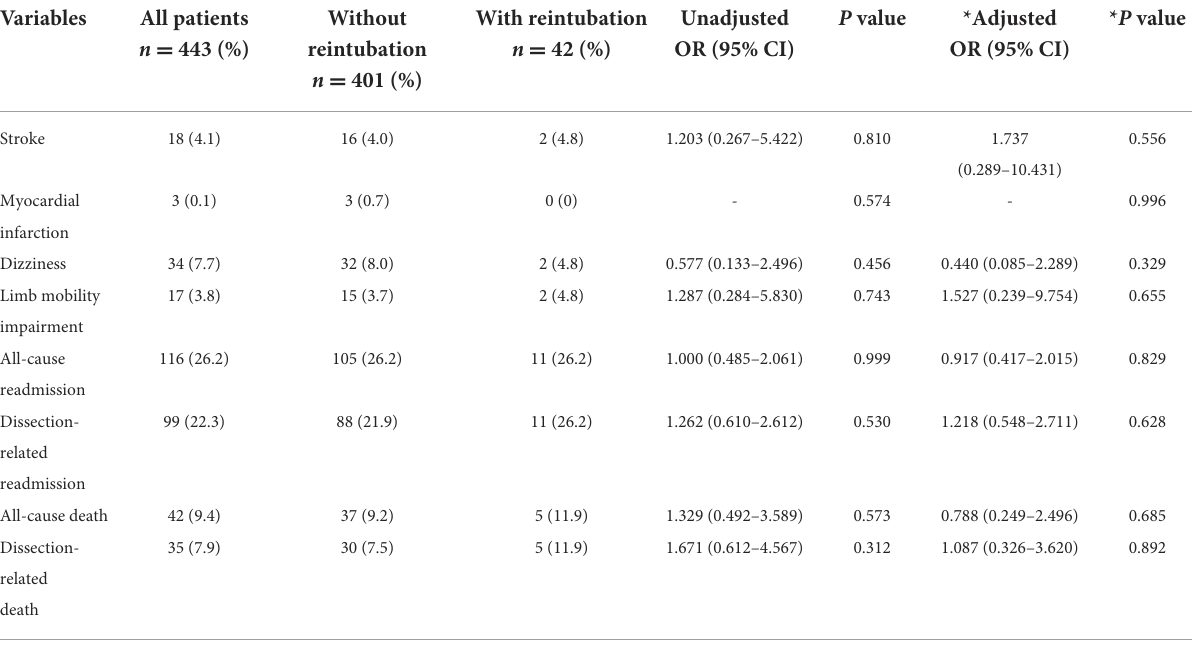
TABLE 5 Long-term follow-up outcomes and comparison in patients with and without reintubation after AADS.